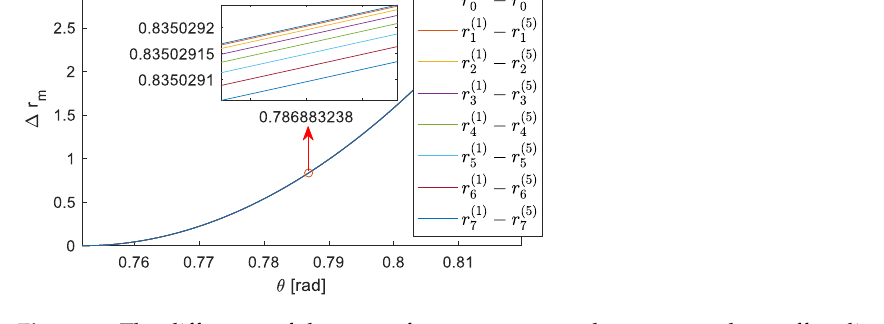
Figure 5. The difference of the range from antennas to the scatterer along off-nadir angle under model 1 and model 5 using the parameters of the simulation experiment mentioned in Section 3.1.